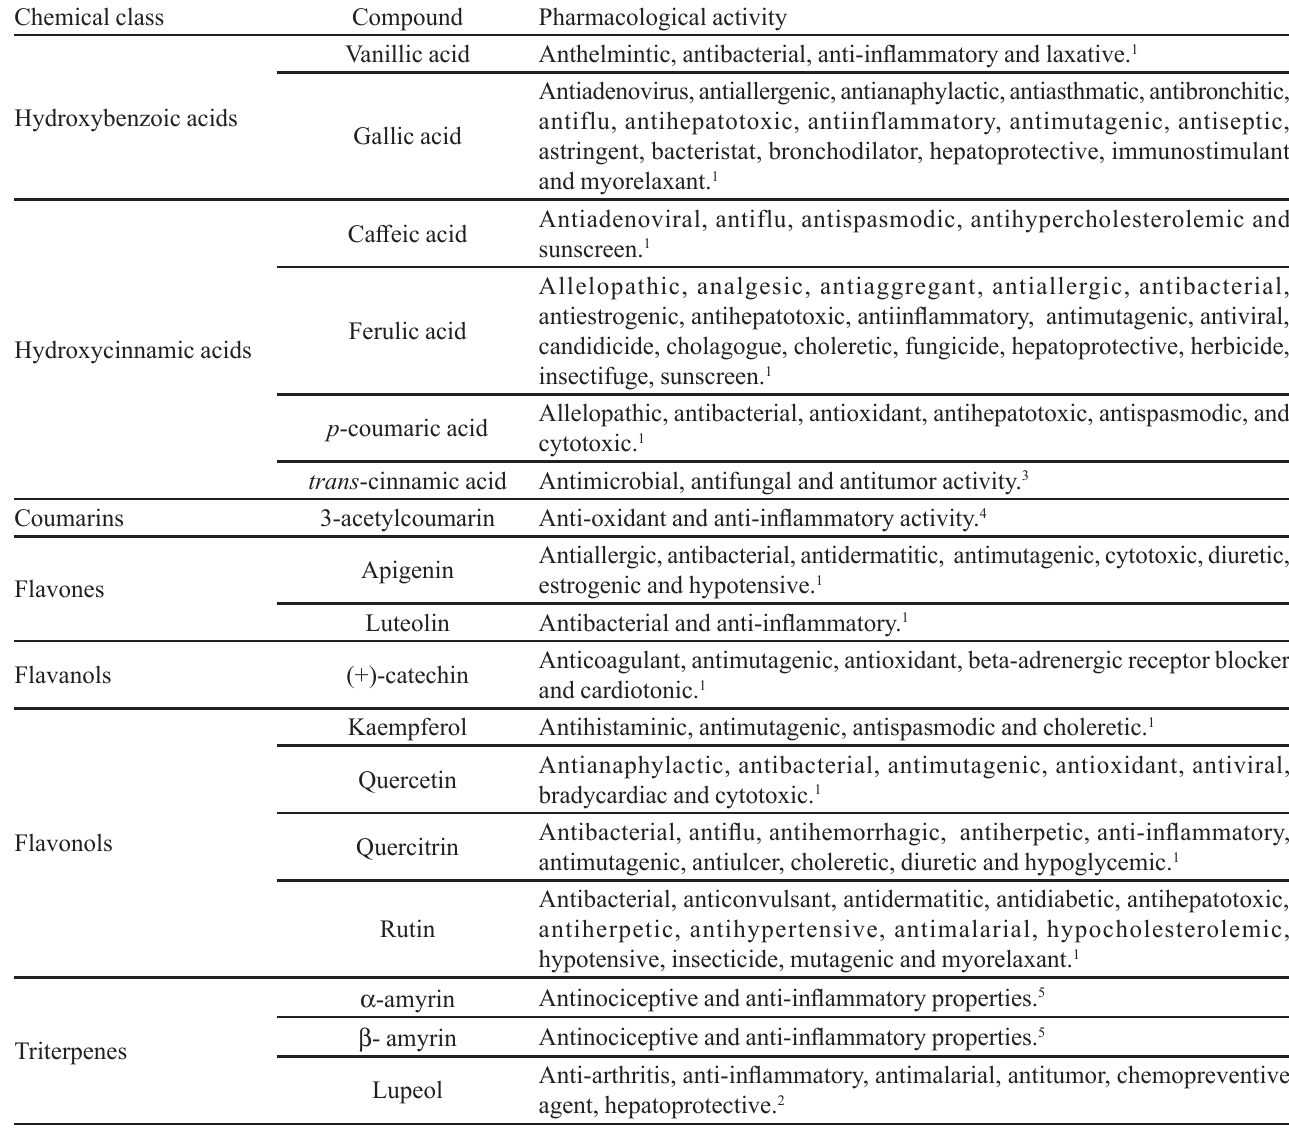
TABLE V - Chemical class and pharmacological activity of compounds isolated from Jatropha gossypifolia Chemical class